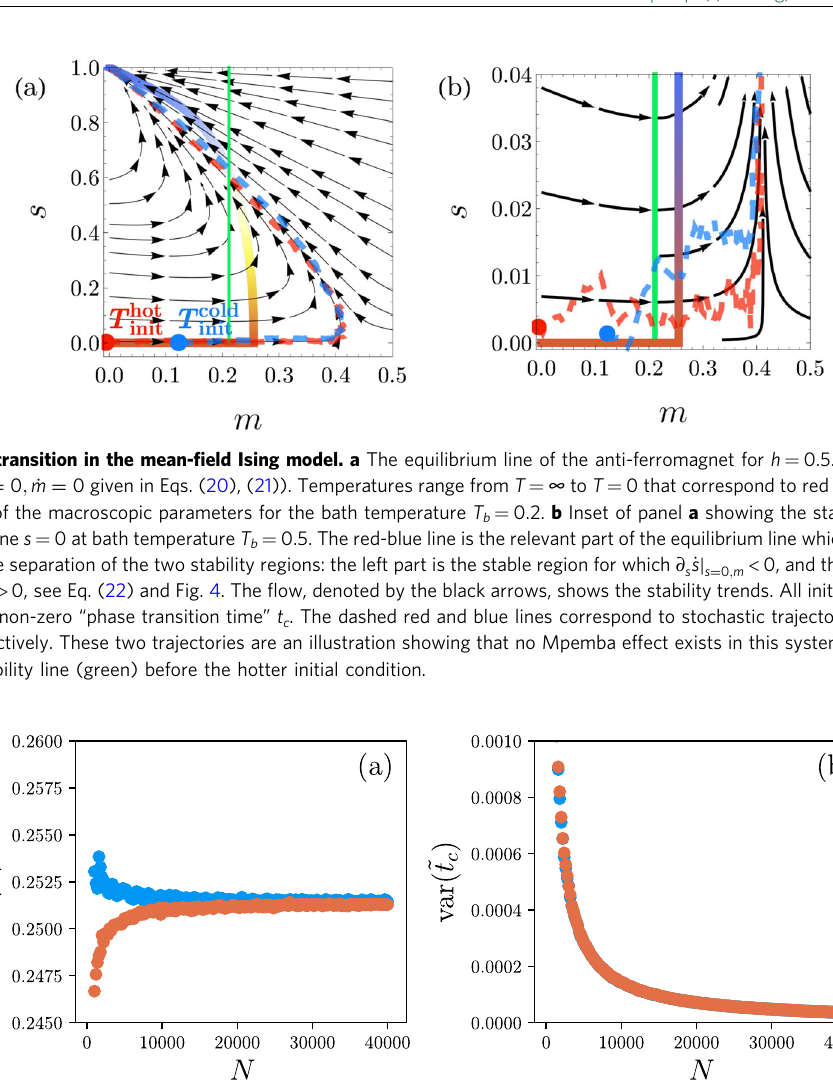
Fig. 6 Convergence of the phase-transition time as function of system size. The mean ( a ) and the variance ( b ) of the “ phase transition time ” ~ t c as a function of the system size N . The time ~ t c is measured in units of Monte – Carlo sweeps, i.e., in units of N . The blue and orange dots correspond to the de fi nitions of ~ t c given by Eqs. ((5), (6)), respectively. The mean is approximately constant, and the variance decreases as N increases. Thus we conclude that ~ t c is a well behaving quantity in the thermodynamic limit. Moreover the two de fi nitions (Eqs. ((5), (6))) for the phase-transition time agree very well for large system